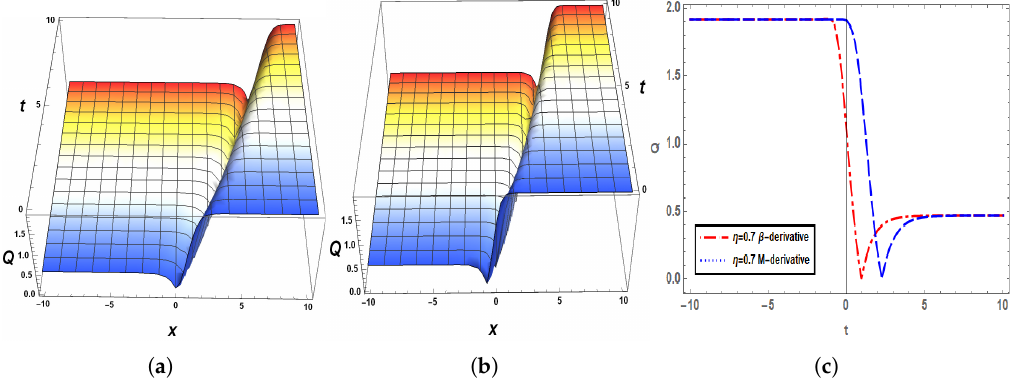
Figure 3. For Q 4,1 ( x , t ) , we take µ = 0.1, γ = − 0.1, σ = 2, θ = 0.5, ϑ = 1, (cid:101) = 2, C = − 1, and λ = 1. Here, ( a – c ) show the 3 D , as well as 2 D graphics letting η = 0.7.